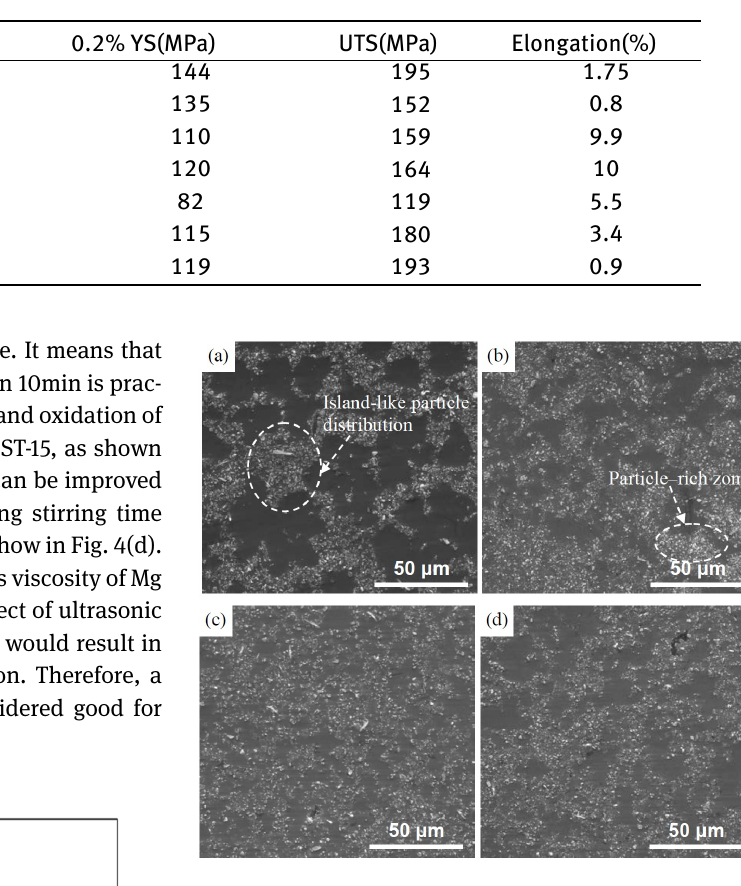
The tensile strength of SiCp/AZ31B composites fab- ricated by semi-solid stirring assisted ultrasonic vibra- tion with different semi-solid stirring time are shown in Fig. 5. Moreover, with the stirring time increasing, the ten- sile strengths of 5 vol.% SiCp/AZ31B composites firstly in- creases and then decreases. By comparison the ultimate strength of composite fabricated at different stirring time, ST-15 is 33 MPa, 5 MPa, and 21 MPa higher than that the of composites produced at 5 min, 10 min and 20 min,